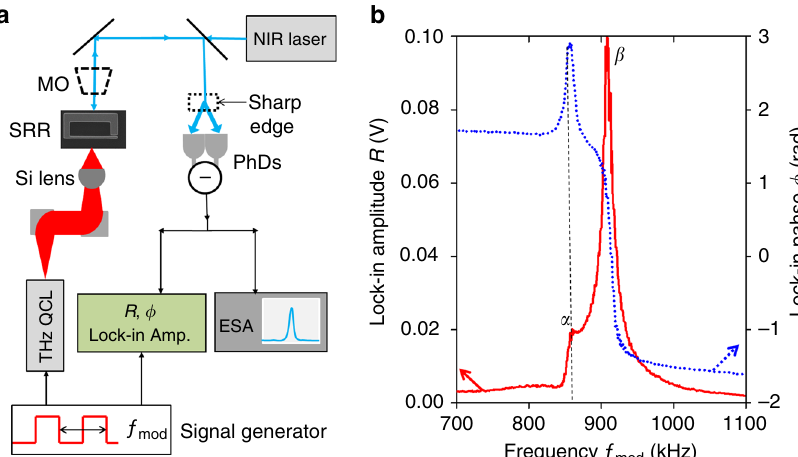
Fig. 3 Terahertz optomechanical characterization. a Experimental setup of the terahertz optomechanical detection scheme. The near-infrared (NIR) laser is focused on the SRR through a microscope objective (MO). The laser beam re fl ected by the cantilever is divided into two parts by a sharp edge plate and sent to a balanced photodetector unit (PhDs). At the same time, the SRR is excited by a THz quantum cascade laser (QCL) with a current modulated by a signal generator at a frequency f mod . The signal from the PhDs is either monitored by an electronic spectrum analyser (ESA) or sent to a lock-in ampli fi er using a square wave reference with a frequency f mod . b Amplitude (full curve) and phase (dotted curve) from the lock-in, obtained as the modulation frequency of the QCL is swept around the mechanical resonances α and β . In this experiment, the Brownian motion spectrum monitored by the ESA is identical to the one of Fig. 2a. The dashed line indicates the position of the α resonance for